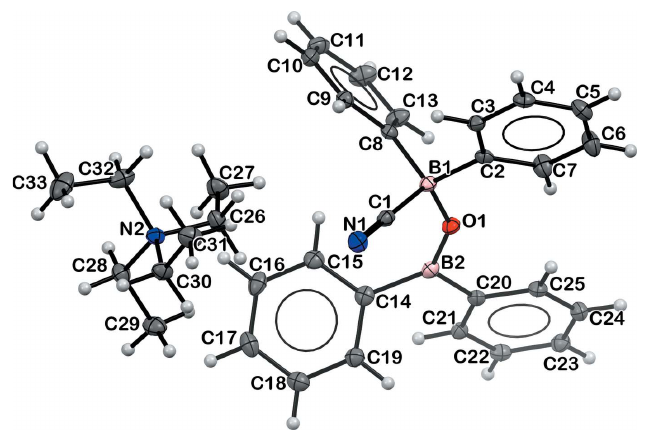
Figure 3 Displacement ellipsoid plot of 3 , [NEt 4 ][NCBPh 2 ( (cid:4) -O)BPh 2 ], drawn at the 50% probability